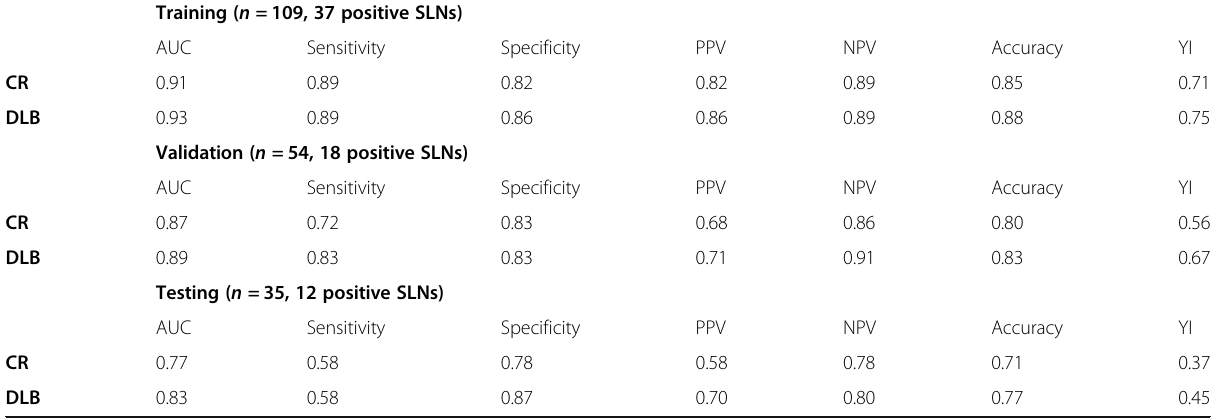
Table 2 Predictive performance results for intratumoral plus 4 mm peritumoral region for CR and DLB models. Values shown are from the random seed with highest training set accuracy. The DLB pipeline slightly outperformed CR in the validation set of the same resolution as the training set. A larger improvement is seen in the testing set of dissimilar resolution. This indicates the DLB pipeline might be more generalizable and less sensitive to pixel size differences